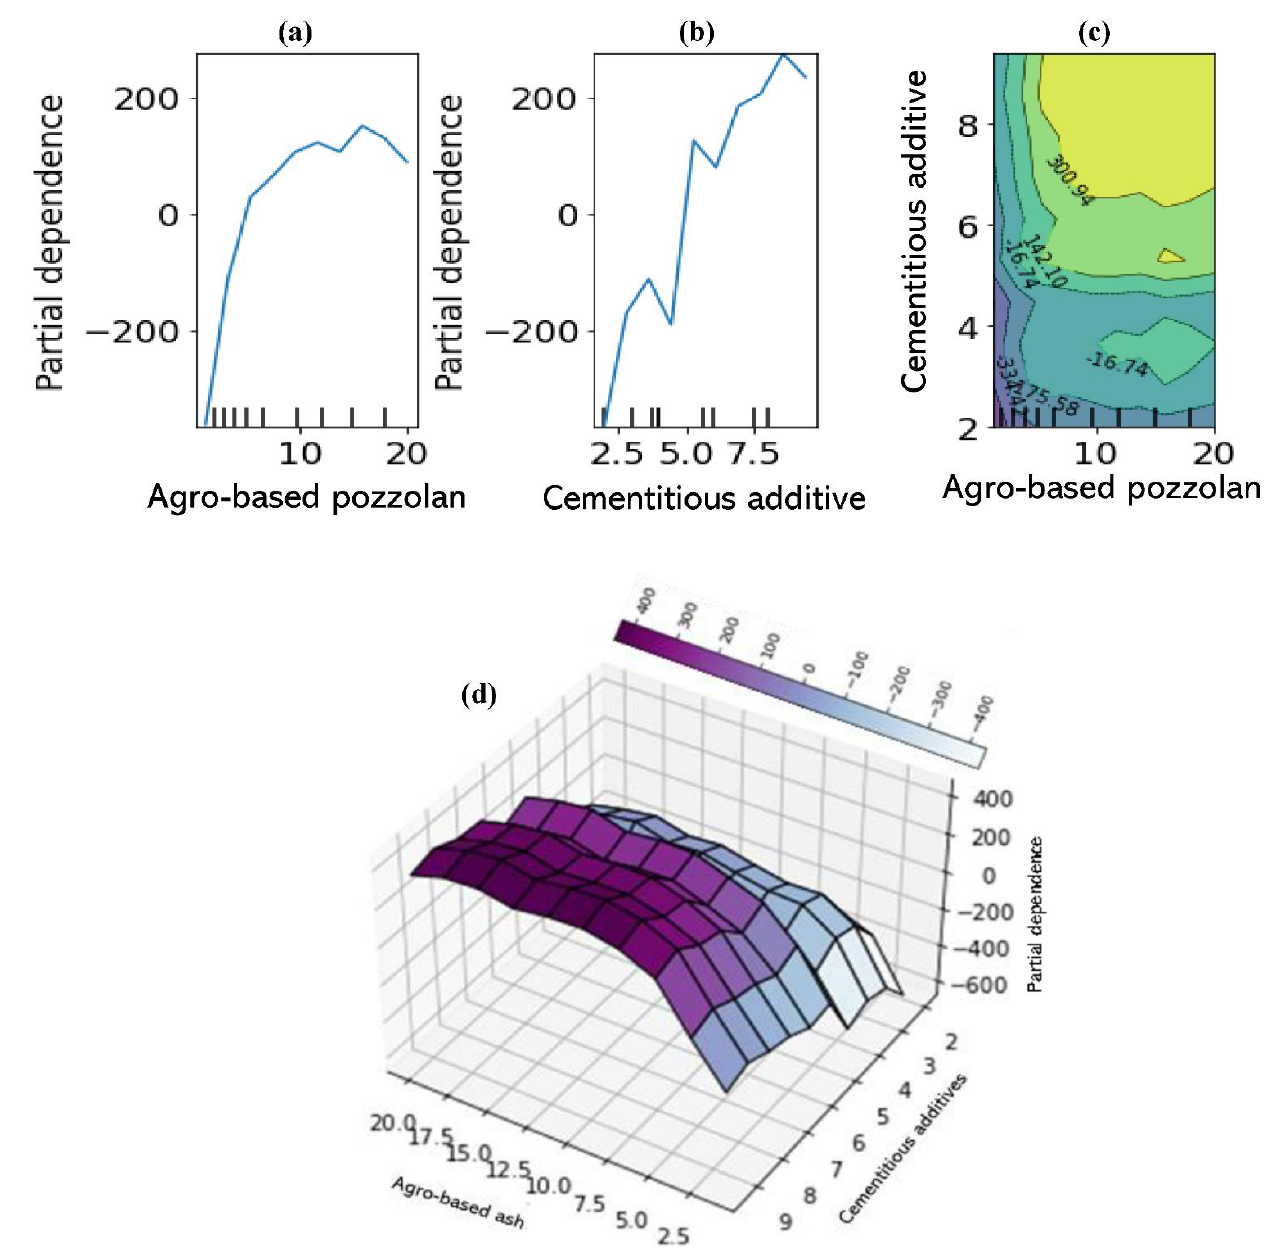
Figure 13. Partial dependence plots: ( a ) one-way dependence for agro-based pozzolan, ( b ) one-way dependence for cementitious additive, ( c ) two-way dependence for additives’ features, ( d ) 3-dimensional two-way dependence for additives’ feature .